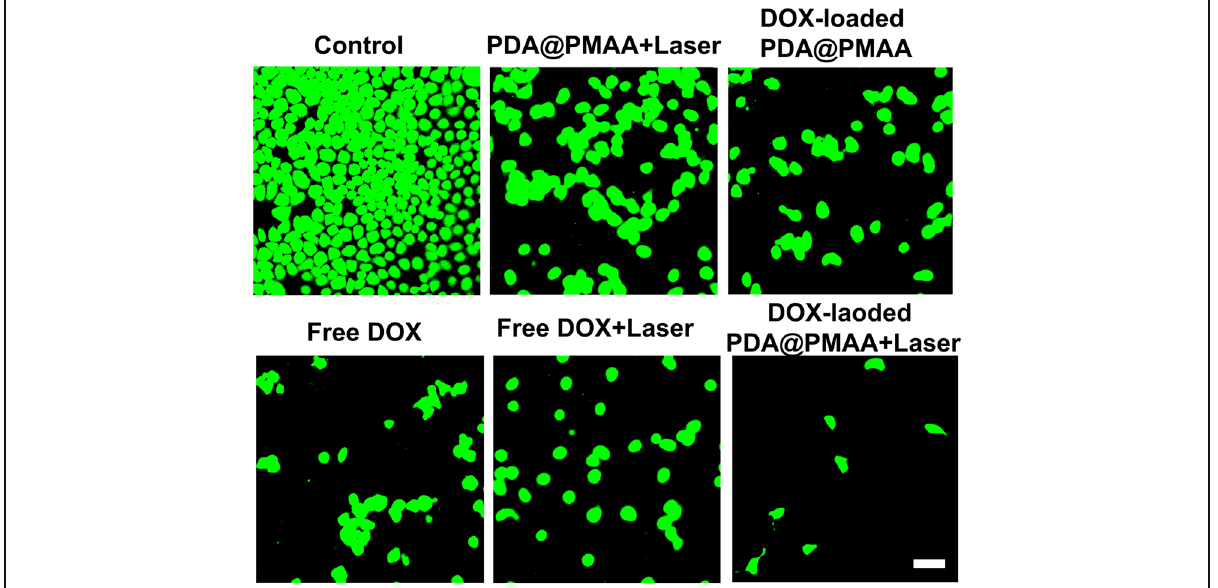
Fig. 10 Confocal fluorescence images of live A549 cells treated with PBS, PDA@PMAA-1 nanoparticles, DOX-loaded PDA@PMAA-1 nanoparticles, and free DOX with or without NIR laser irradiation ( λ = 808 nm, 5 W cm − 2 ) for 300 s. Live cells were stained with Calcein-AM (green). The scale bar is 50 μ